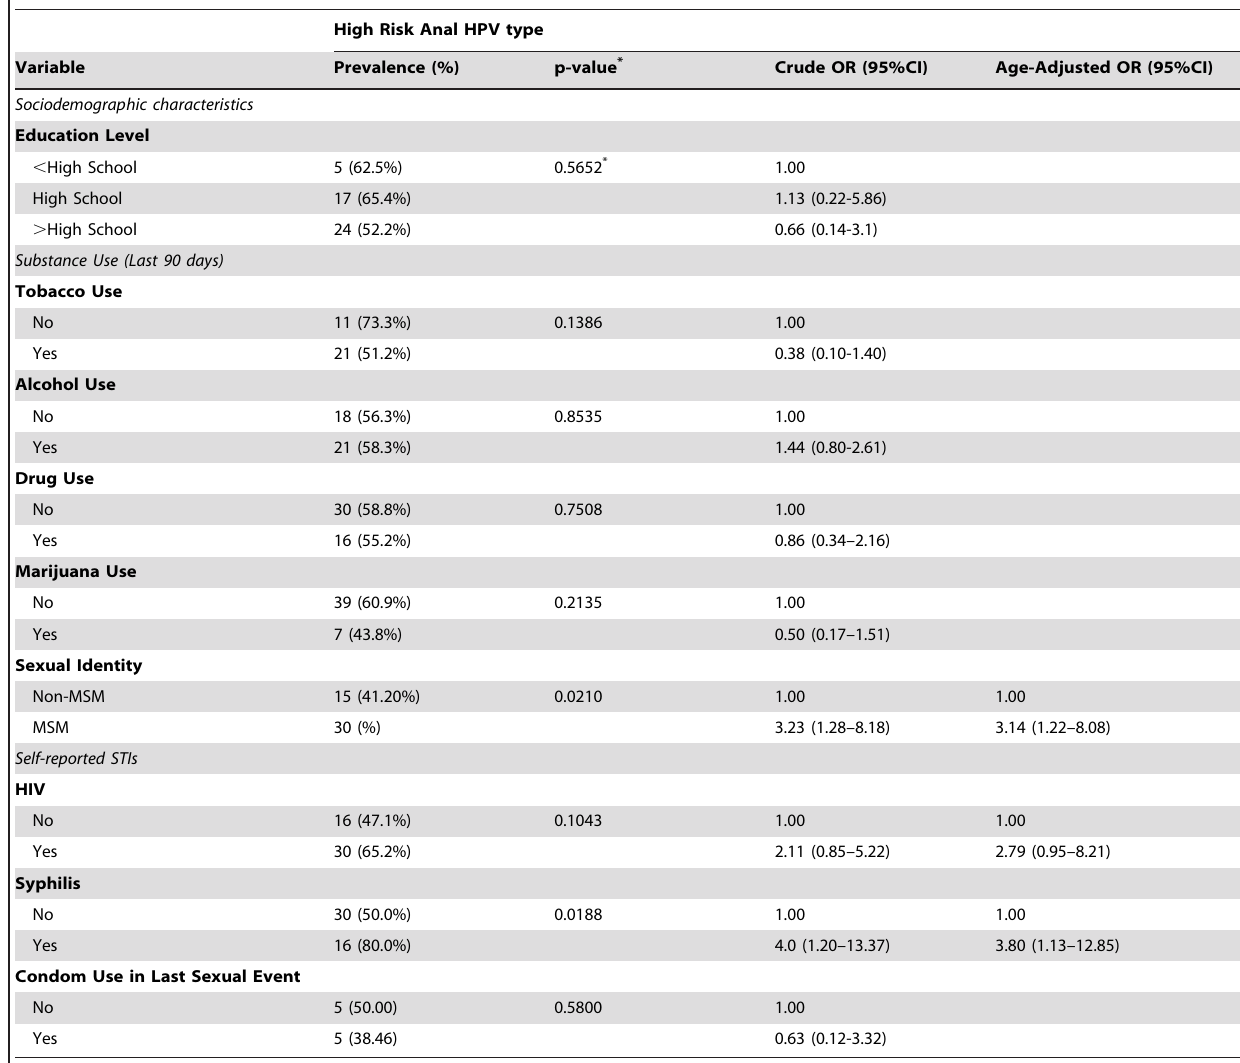
Table 4. Prevalence and Correlates Associated with High Risk Anal HPV